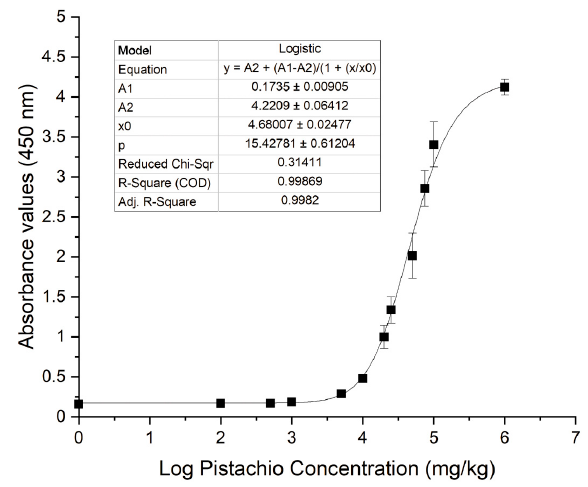
Figure 9. Standard curve of the phage-dAb enzyme-linked immunosorbent assay (ELISA) performed with protein extracts obtained from ground defatted pistachio ( ■ ) in corn flour binary mixtures. The plot shows the average values and the standard deviations corresponding to duplicate experiments performed in three di ff erent